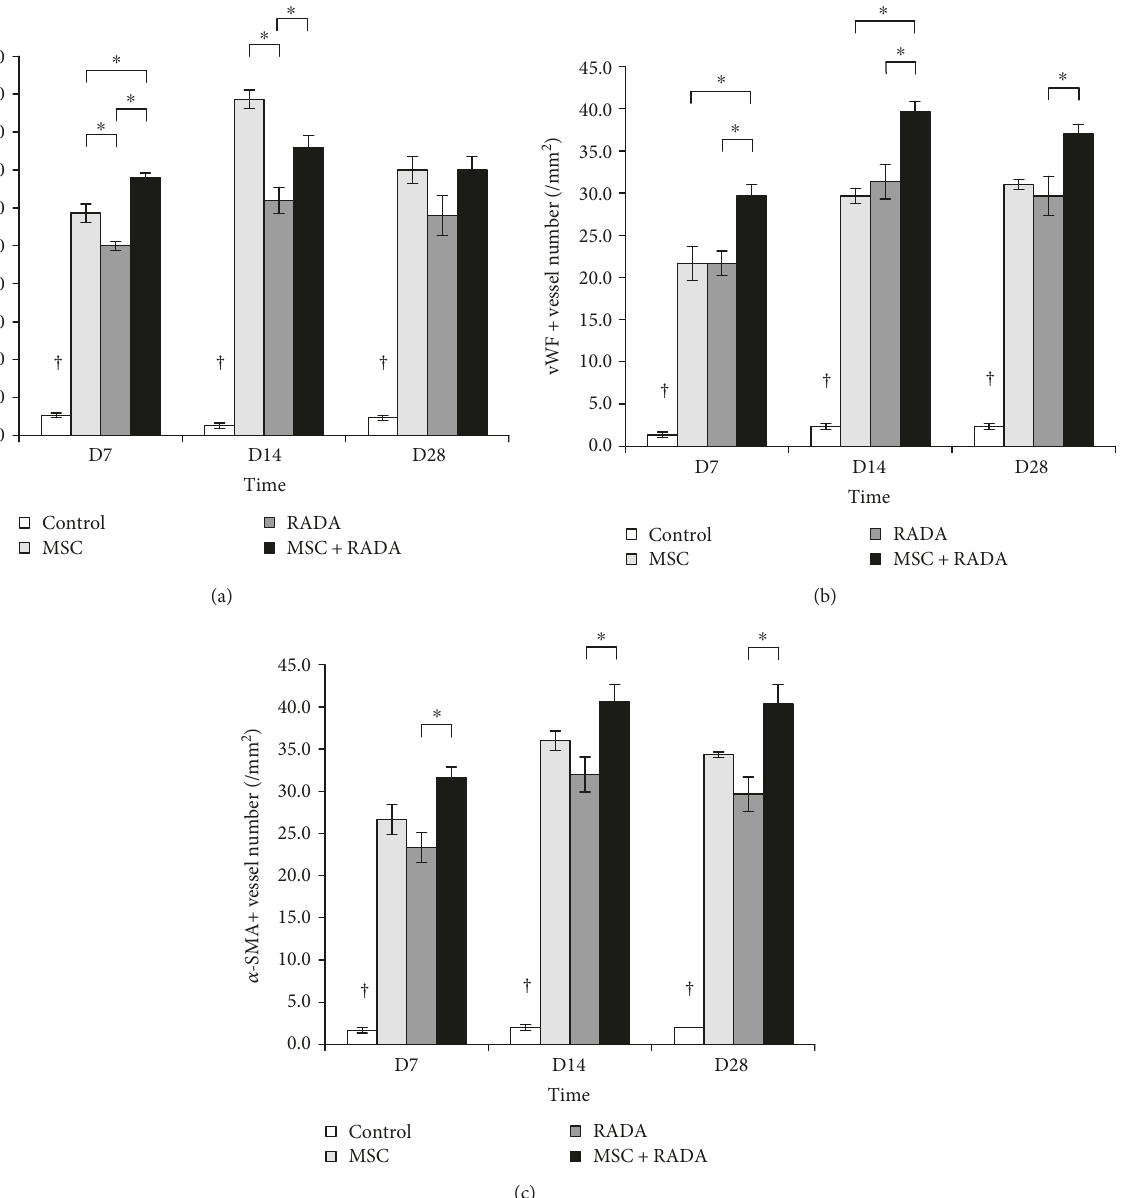
Figure 3: Quanti fi cation of angiogenesis from immunohistochemical staining for MSCs, RADA, MSCs +RADA, and control. The markers (a) CD31, (b) vWF, and (c) α -SMA were used to determine angiogenesis and the overall results demonstrate an increase in marker